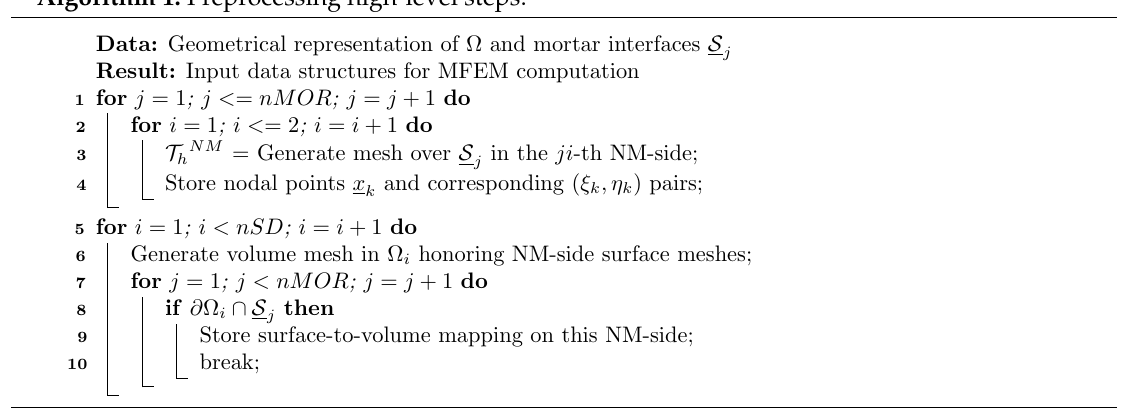
Algorithm 1: Preprocessing high-level